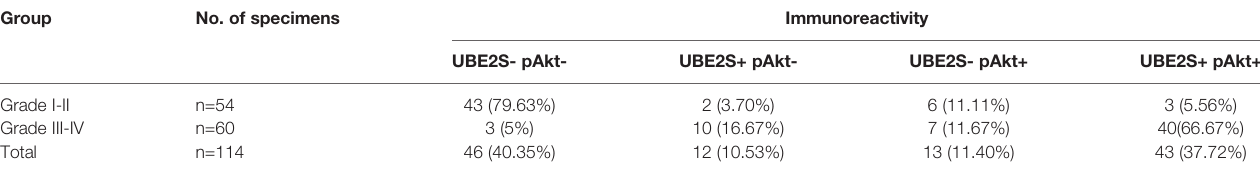
TABLE 2 | Association of UBE2S and pAkt immunoreactivity with glioma.